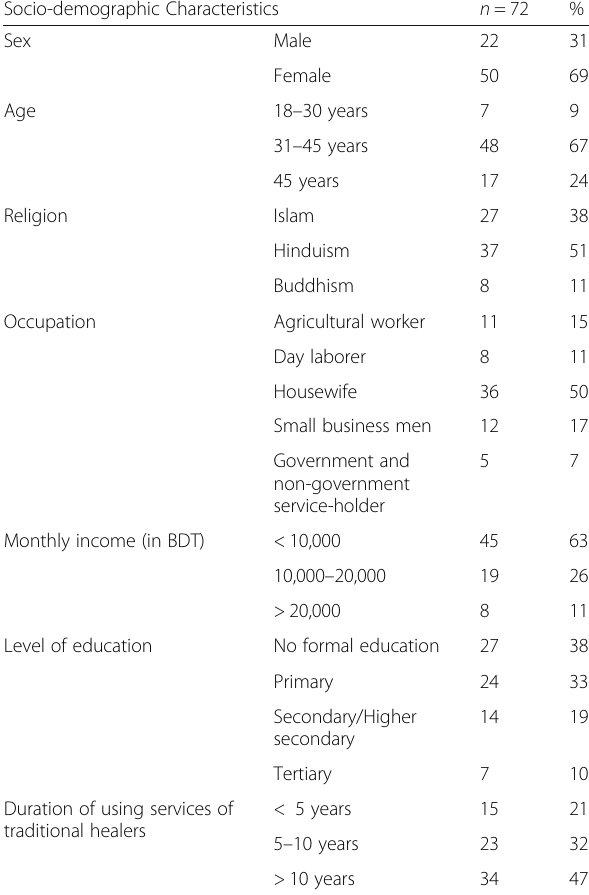
Table 3 Socio-demographic characteristics of patients from traditional